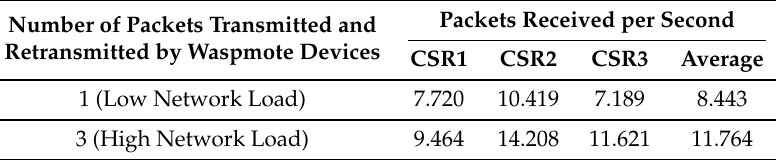
Table 15. Packet per second received by CSR devices when they retransmit each packet 3 times (default mode). Waspmote devices configured as Collaborative